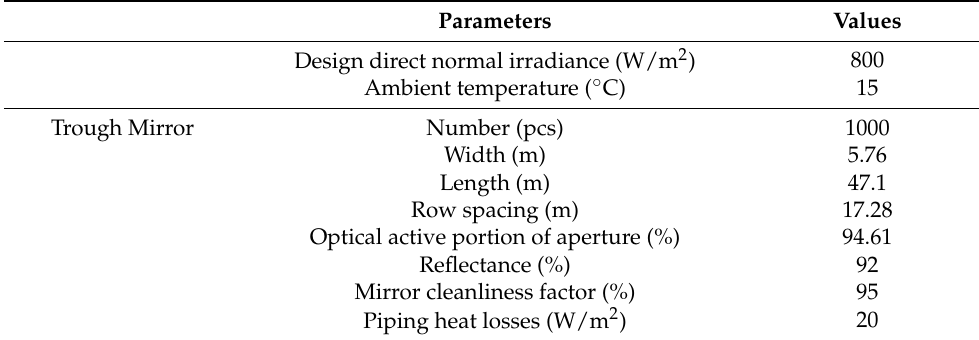
Table 6. Design parameters of parabolic trough solar